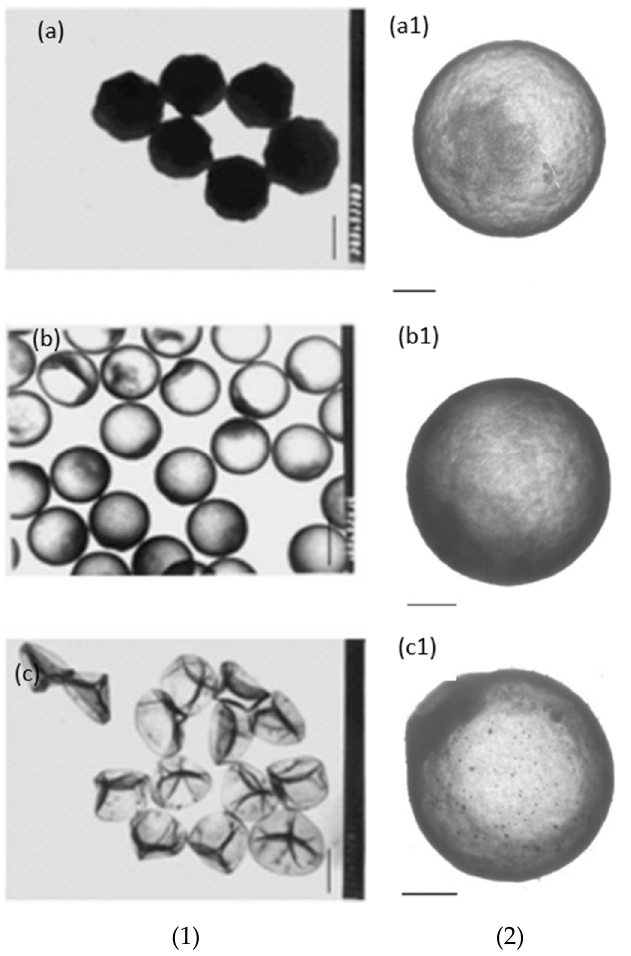
Figure 14. (1) TEM images of silica spheres prepared at different amounts of ammonia of ( a ) less than 0.030 g/mL, ( b ) 0.045 g/mL, and ( c ) more than 0.045 g/ml; (2) TEM images of hollow silica prepared at 0.045 g/mL ammonia with different amounts of TEOS: ( a1 ) 0.10 g/mL, ( b1 ) 0.15 g/mL, and ( c1 ) 0.18 g/mL. The scale bar is 1 µ m (modified original image) [77]. H. Zou et al. [80] used PVP stabilised PS in non-aqueous solutions to prepare hollow silica spheres, where the PS was removed via dissolution in the same medium. TEOS was added dropwise, and KPS was used as an initiator to produce negatively charged PS. The percentage of PVP on the PS surface increased while the size of PS decreased when the concentration of PVP was raised during the synthesis of PS. It was suggested that PVP on the surface acts as a coupling agent. Low ammonia (0.003 g/mL) resulted in a uniform coating with a smooth surface, while high ammonia (above 0.012 g/mL) produced a rough surface with large amounts of free silica. Rough surfaces were arguably brought about by fast reaction kinetics due to the high ammonia concentration, which also caused high sec- ondary nucleation. Complete precipitation was observed at 0.048 g/mL ammonia, while larger silica particles were seen at higher ammonia concentrations. However, at low am- monia (0.003 g/mL), no hollow structure was formed due to a low dissolution rate, but it was shown that dissolution could be improved by increasing the temperature (70 °C). At this temperature, complete dissolution was achieved, and 0.006 g/mL was the minimum concentration of ammonia needed to produce a hollow silica sphere. It was found that increasing TEOS concentration by dropwise addition made the shell thicker and increased the etching time. However, incomplete etching and composite particles were still seen at higher ammonia concentrations and longer dissolution times. It was concluded that